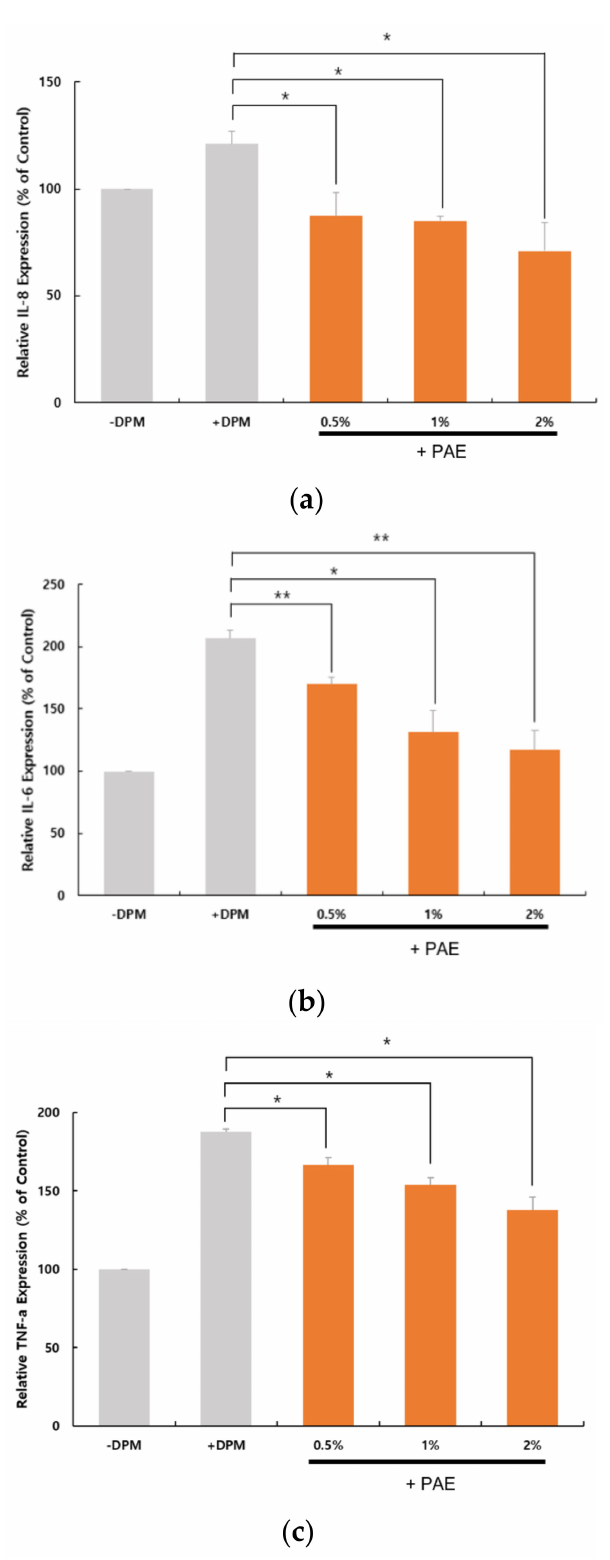
Figure 5. DPM upregulated proinflammatory cytokines and tumor necrosis factor- α (TNF- α ). HaCaT cells were treated with DPM only or DPM and PAE. Transcriptional regulation of interleukin-8 (IL-8) ( a ), IL-6 ( b ) and TNF- α ( c ) indicates that DPM induces inflammatory responses, which could be inhibited by PAE in a concentration-dependent manner. (* p < 0.05, ** p <